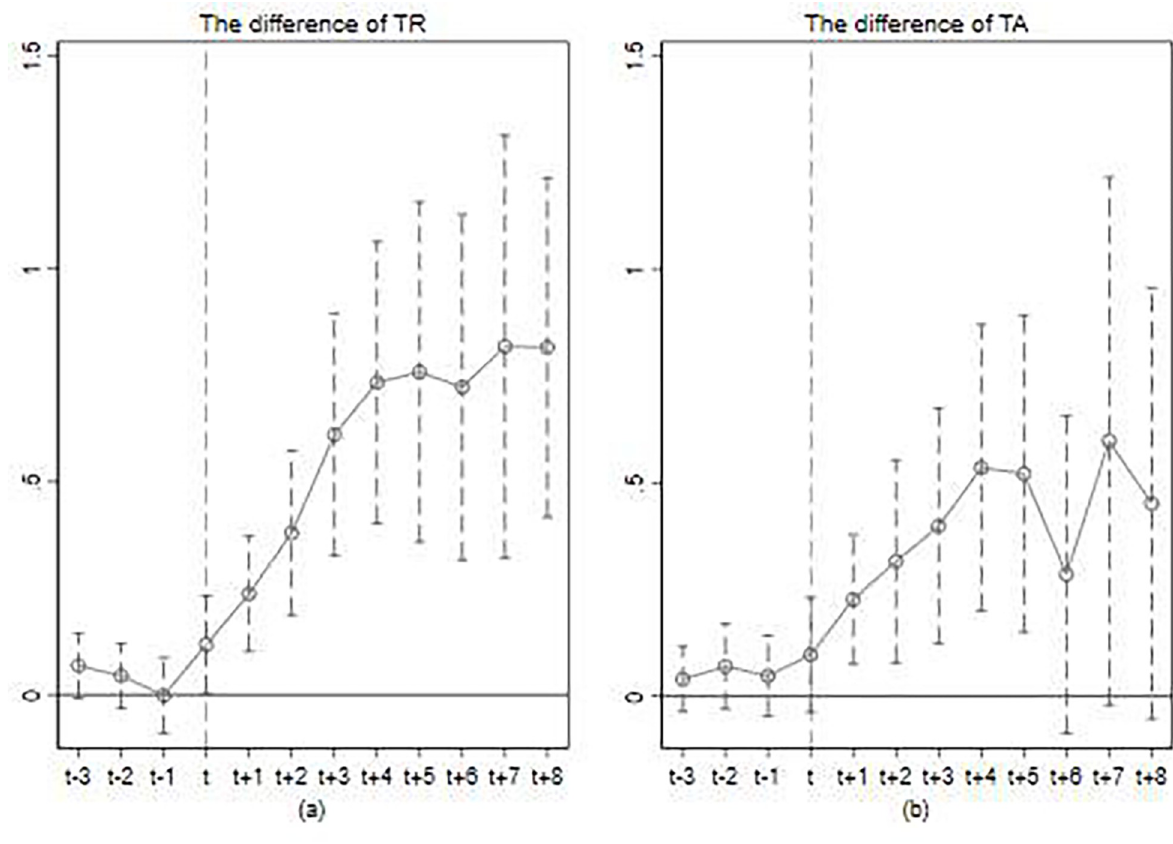
Fig 3. Results of the parallel trend test for TR and